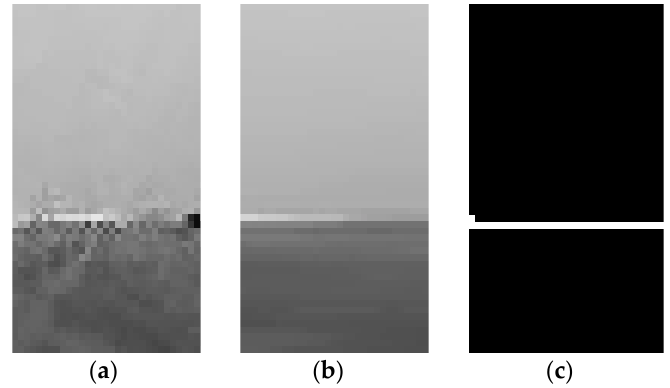
Figure 7. The processing result of the selected target object region in the image—( a ) The original ROI, ( b ) The ROI processed through median filter, ( c ) The ROI processed through edge detection.